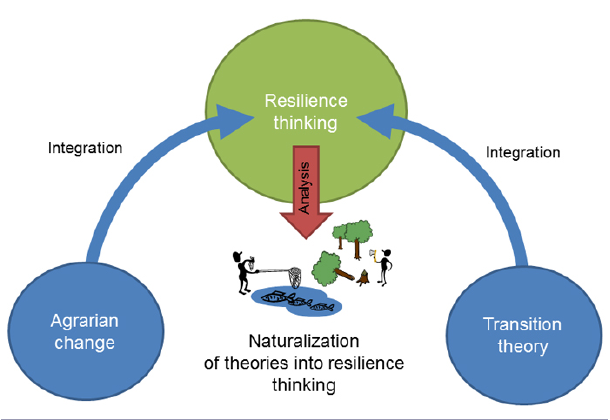
Fig. 1 . Naturalization of theories and concepts into resilience